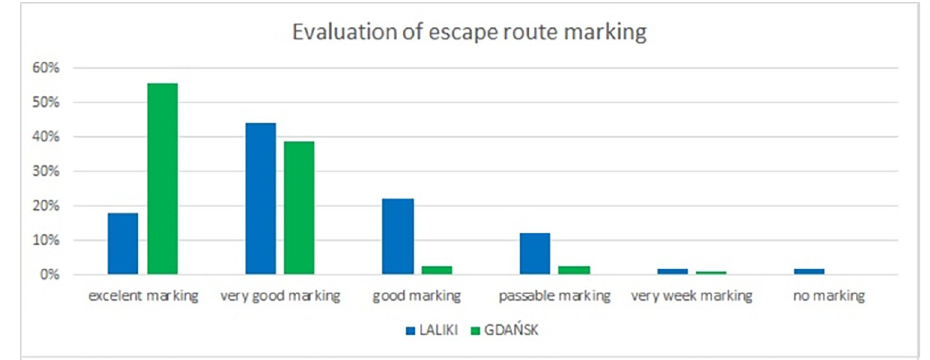
Fig 8. Pedestrians’ estimation of the escape route marking (results from Experiment 1).